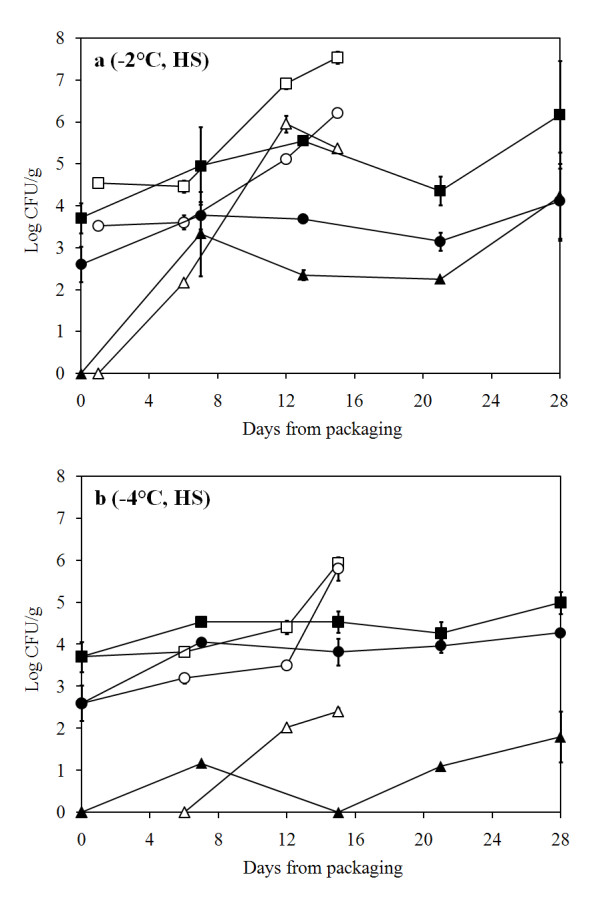
Bacterial growth in air and MA cod loins (HS). Bacterial growth in air- and MA-packaged cod loins (HS) during storage at A) -2°C and B) -4°C. (black square) Total psychrotrophic viable counts in MA, (white square) total psychrotrophic viable counts in air, (black circle) presumptive Pseudomonas counts in MA, (white circle) presumptive Pseudomonas counts in air, (black triangle) P. phosphoreum in MA and (white triangle) P. phosphoreum in air.